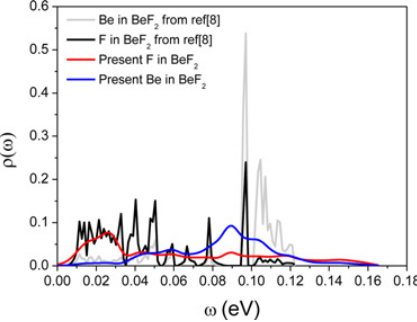
Figure 3. The calculated partial PDOSs of Be and F atoms.